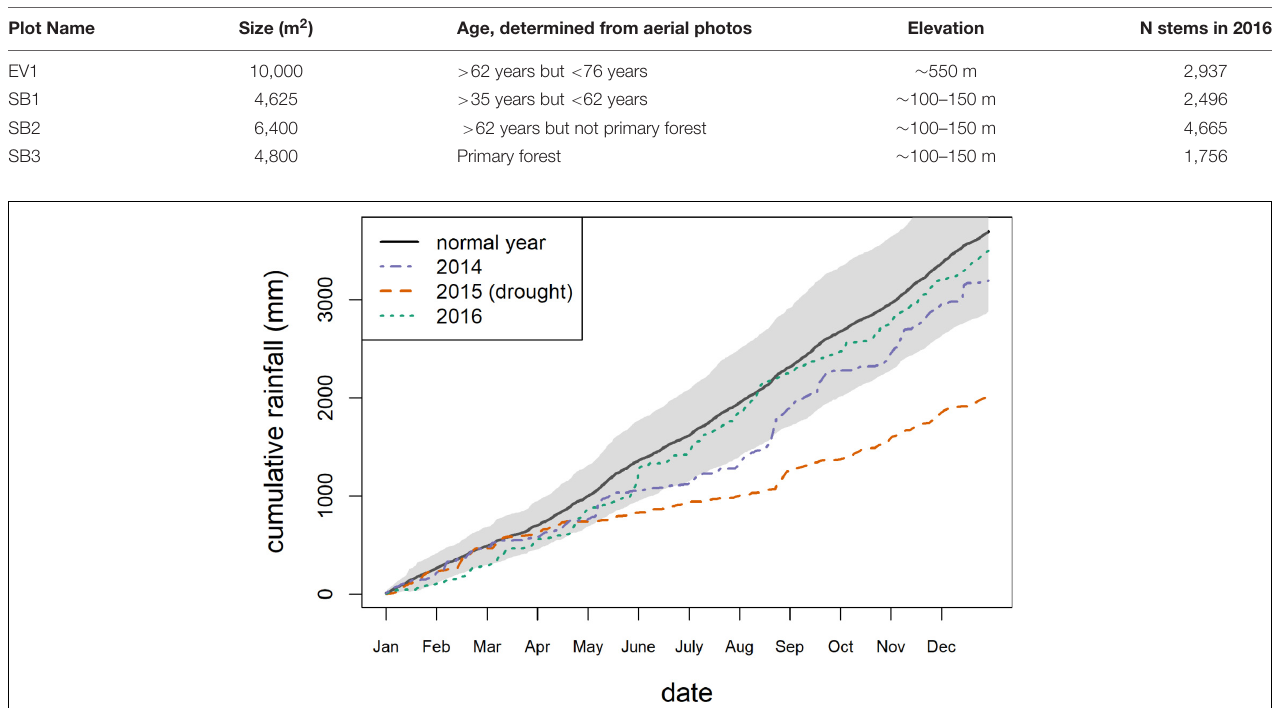
FIGURE 1 | Cumulative rainfall in El Yunque National Forest. Solid black line indicates 1975–2014 average with the gray shaded area representing mean cumulative rainfall plus/minus one standard deviation.